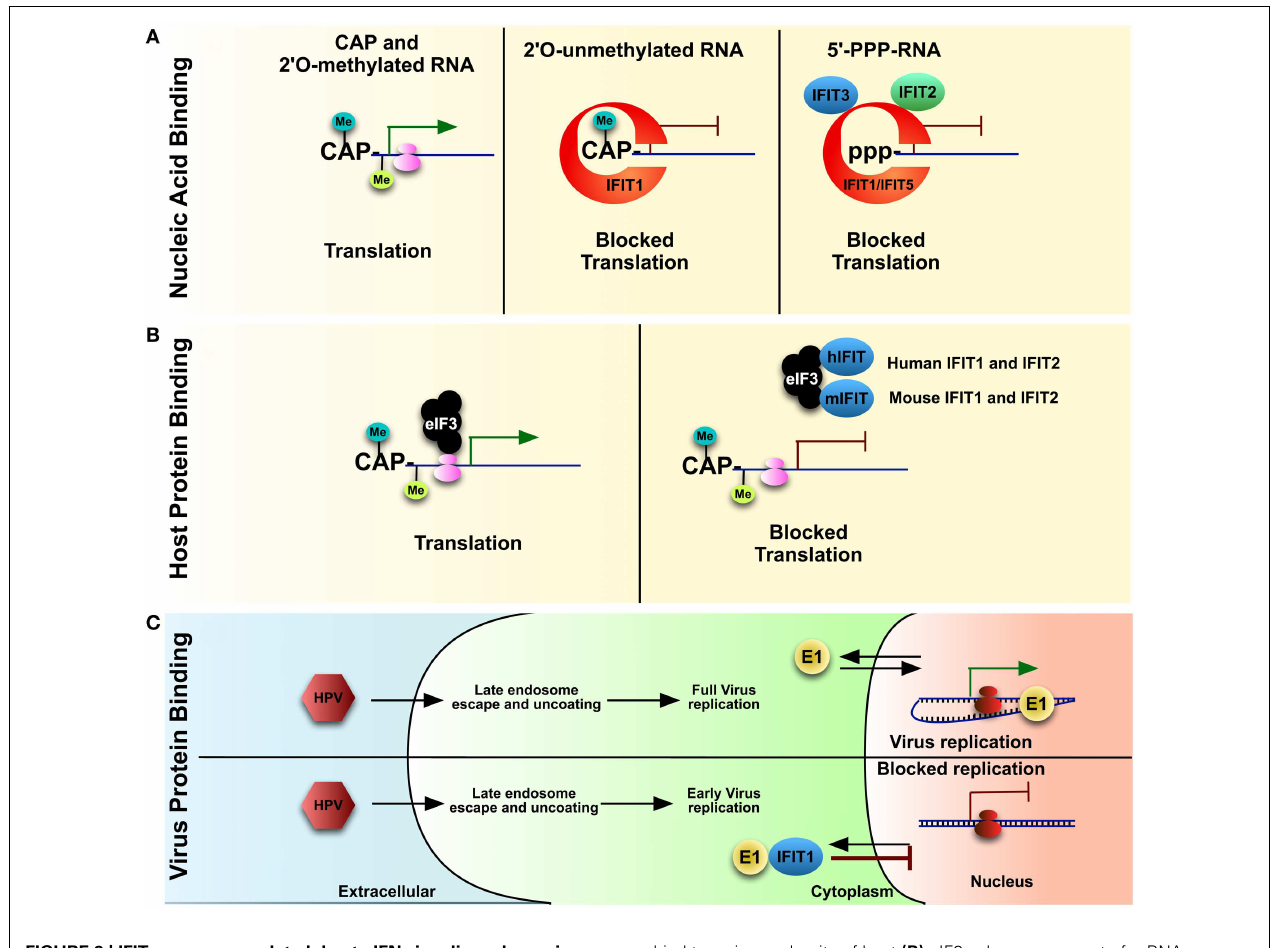
FIGURE 2 | IFITs, once upregulated due to IFN signaling, play various roles in blocking virus and host protein translation . IFIT1 can bind to the (A) 5 (cid:48) of mis-modified RNA either which is 2 (cid:48) - O -unmethylated or has 5 (cid:48) PPP-RNA (features of foreign nucleic acid) vs. properly capped host mRNA. IFIT1, along with a complex of IFIT2 and IFIT3, can block translation of these nucleic acids. Multiple IFITs have been described to